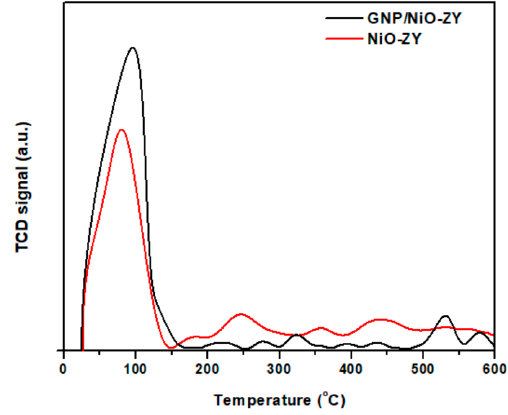
Figure 5. TPD-NH 3 profiles of GNP/NiO-ZY and NiO-ZY.